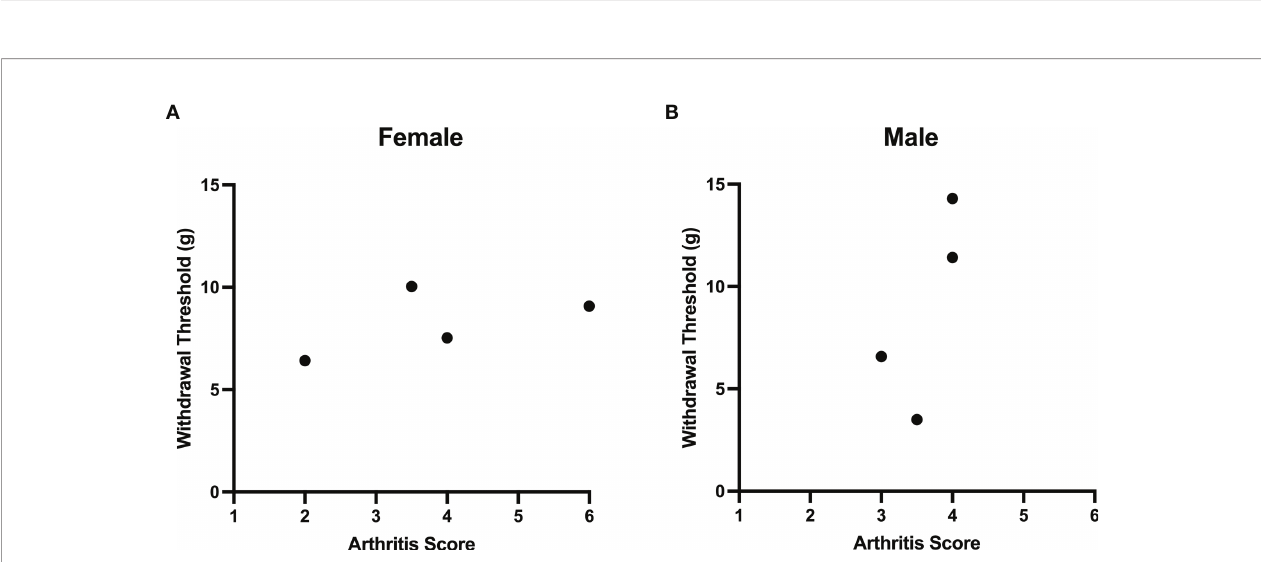
FIGURE 4 | Lack of correlation between LPA-induced joint damage and mechanonociception. A comparison of arthritis score and secondary mechanical allodynia failed to demonstrate any correlation between these two parameters in both female (A) and male (B) rats treated with LPA. (Females: Spearman ’ s rank coef fi cient r = 0.4, P = 0.75, n = 4; male: Spearman ’ s rank coef fi cient r = 0.7, P = 0.33, n = 4).